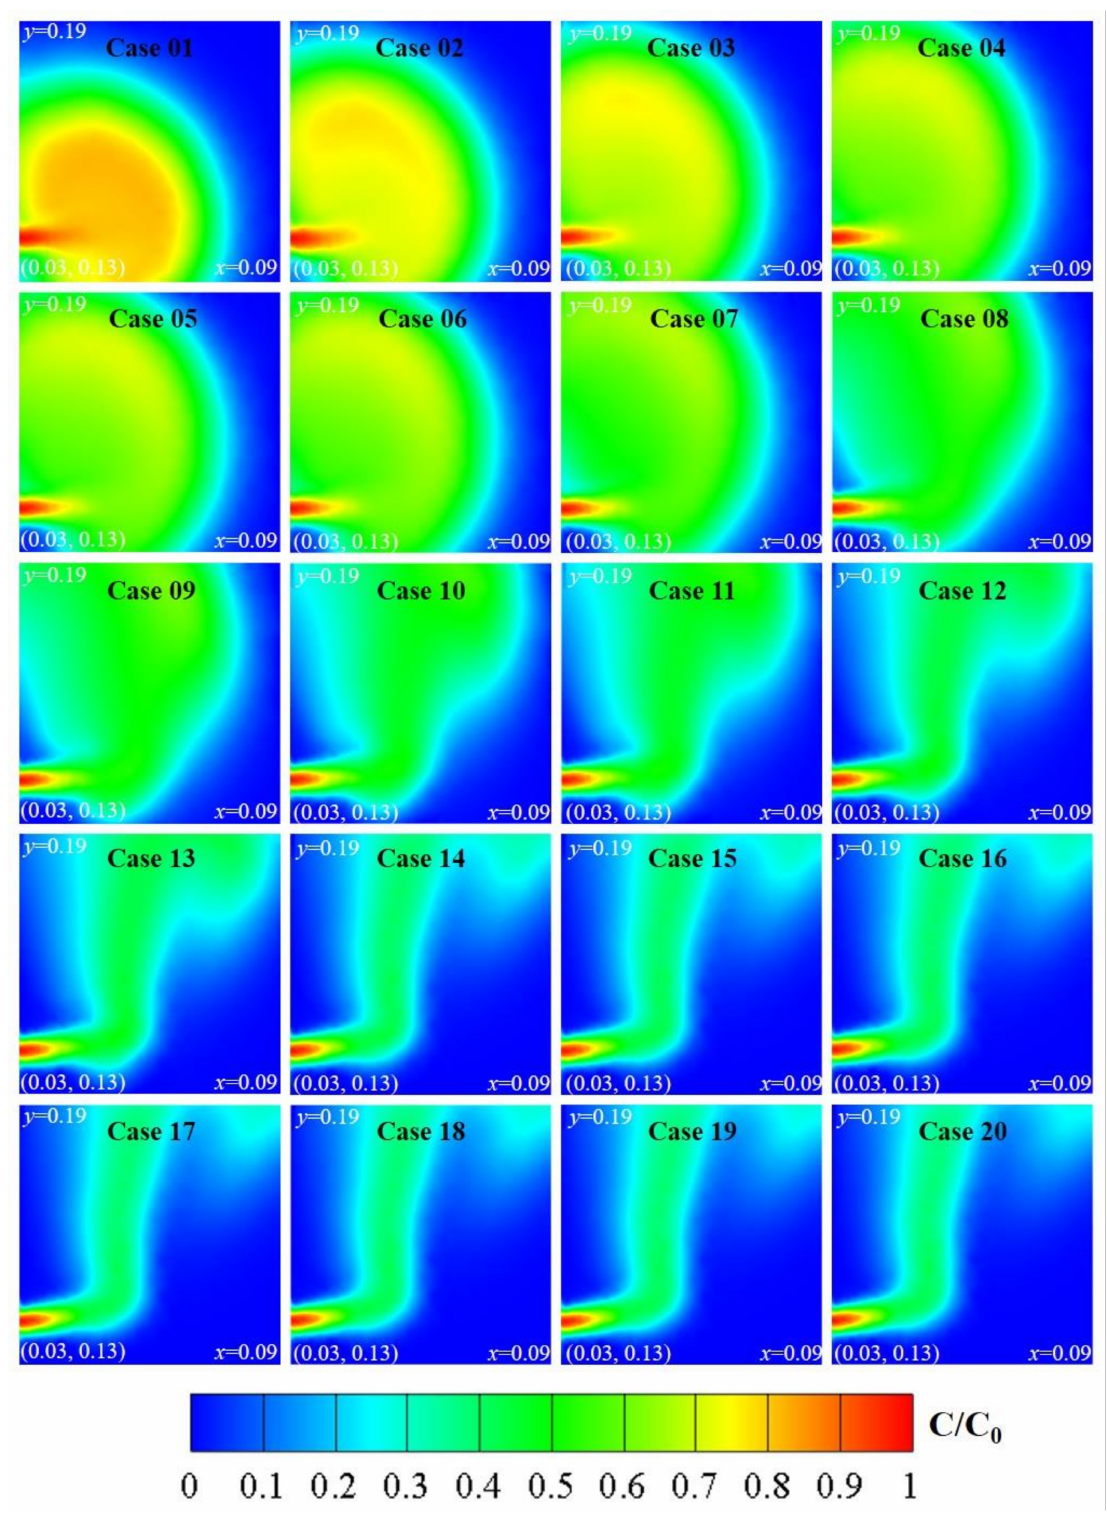
Figure 3. The normalized concentration field at the central plane for different cases obtained by the CFD model.